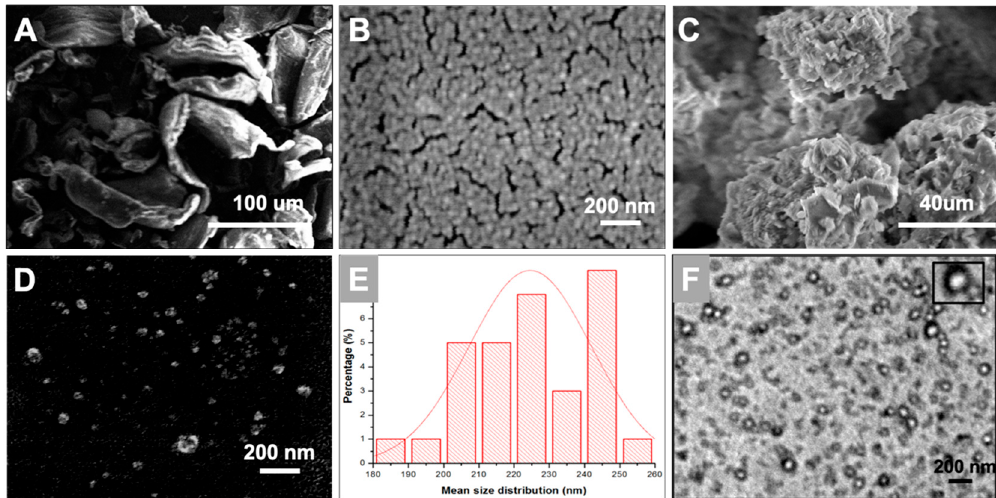
Figure 2. Scanning Electron Microscopy images of ( A ) chitosan powder; ( B ) freshly prepared CS Np and ( C ) and ( D ) lyophilized CS Np. Further, ( E) depicts the average size distribution of the nanoparticles obtained from scanning electron microscopy. Whereas, ( F ) depicts the transmission electron microscopic image of chitosan nanoparticles.